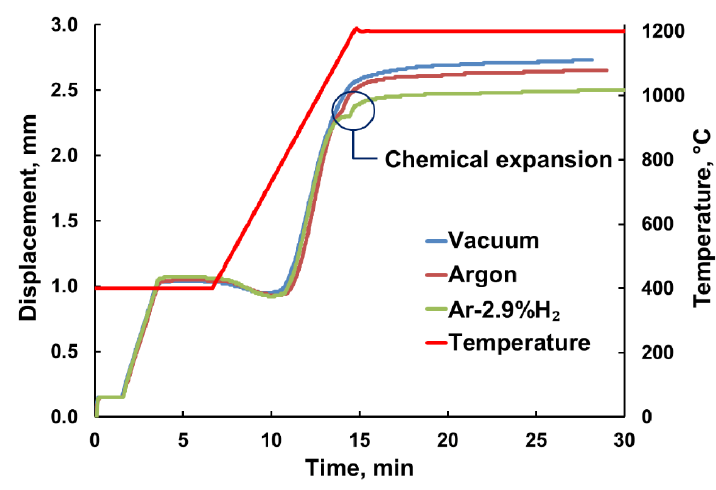
Figure 6. Measured displacement during pressure-assisted FAST/SPS of GDC10-HP powder in different atmospheres.